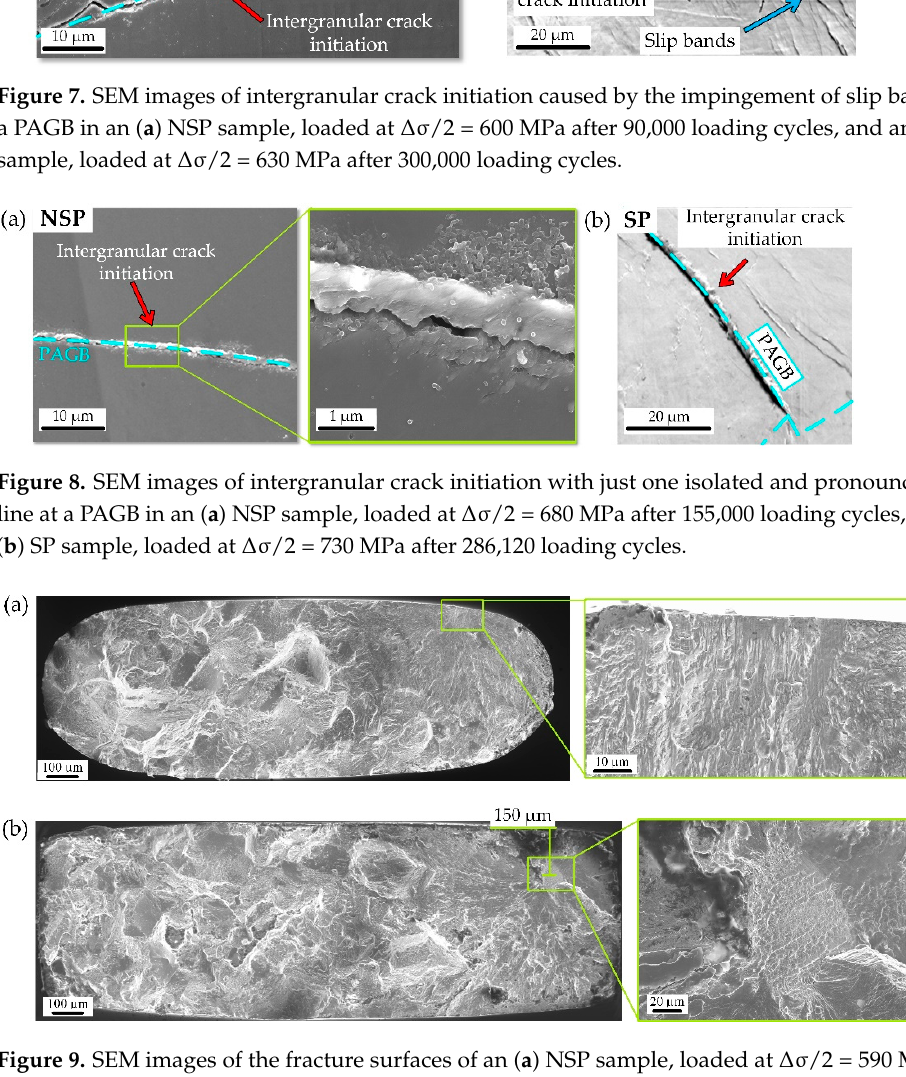
Figure 9. SEM images of the fracture surfaces of an ( a ) NSP sample, loaded at ∆σ /2 = 590 MPa for 271,000 loading cycles, and an ( b ) SP sample, loaded at ∆σ /2 = 730 MPa for 286,120 loading cycles.